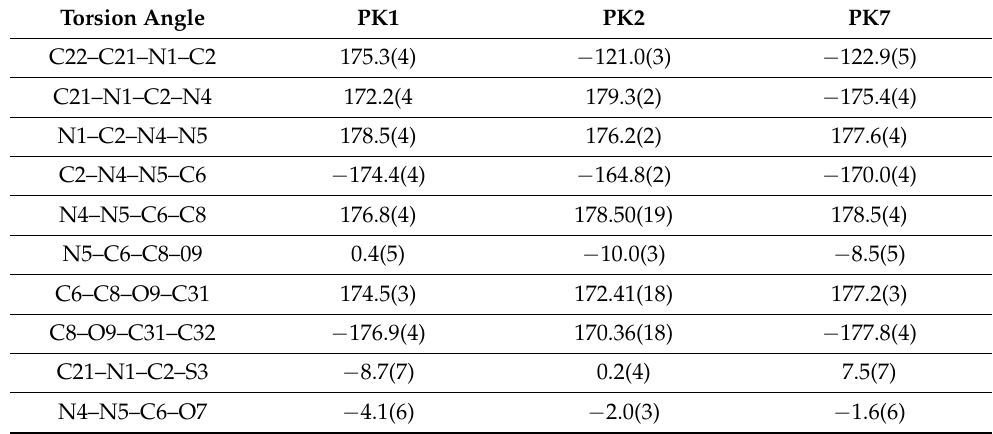
Table 2. Selected torsion angles ( ◦ ).